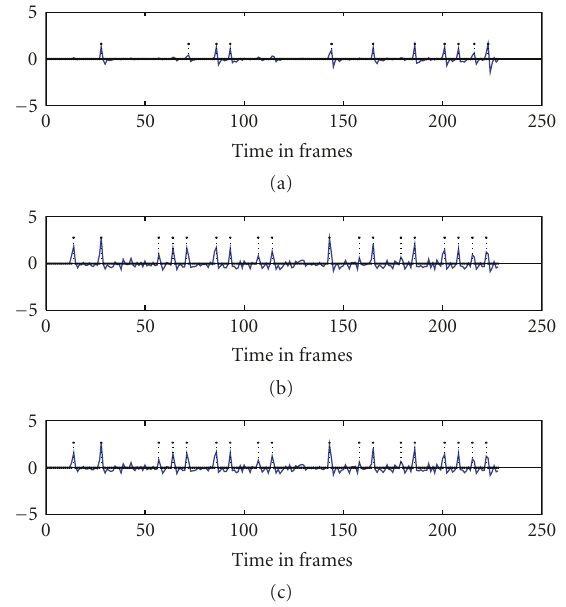
Figure 16: Comparison between the detection functions for the real guitar signal (see Figure 14). Plots (a), (b) and (c) are detection ( k ), h o ( k ), and h o ( k ), respectively, where the detected functions h o a r b onsets using these functions are marked with stars.